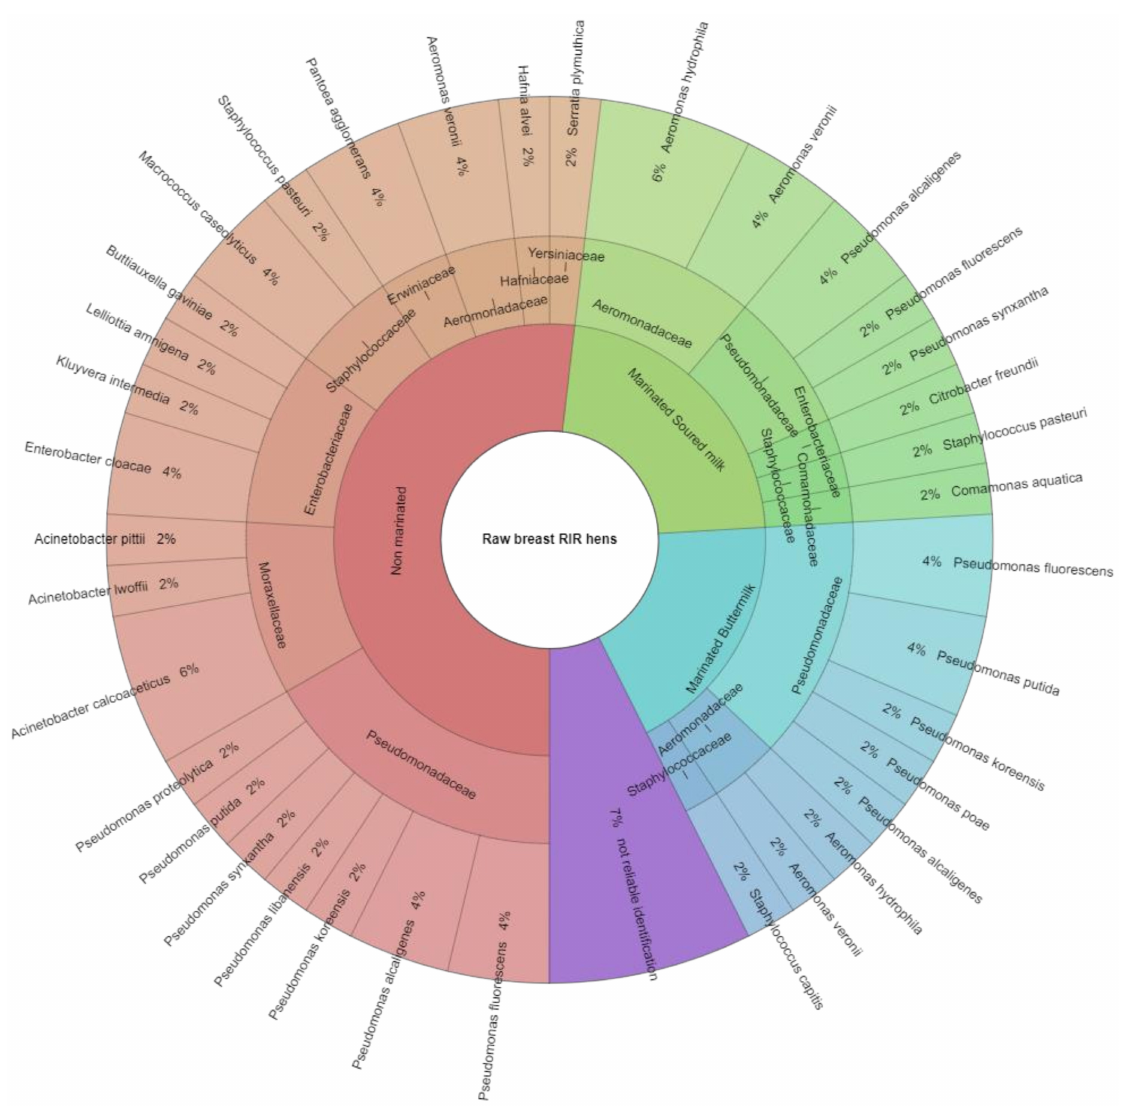
Figure 1. Bacteria identified in samples of raw meat from RIR hen breast